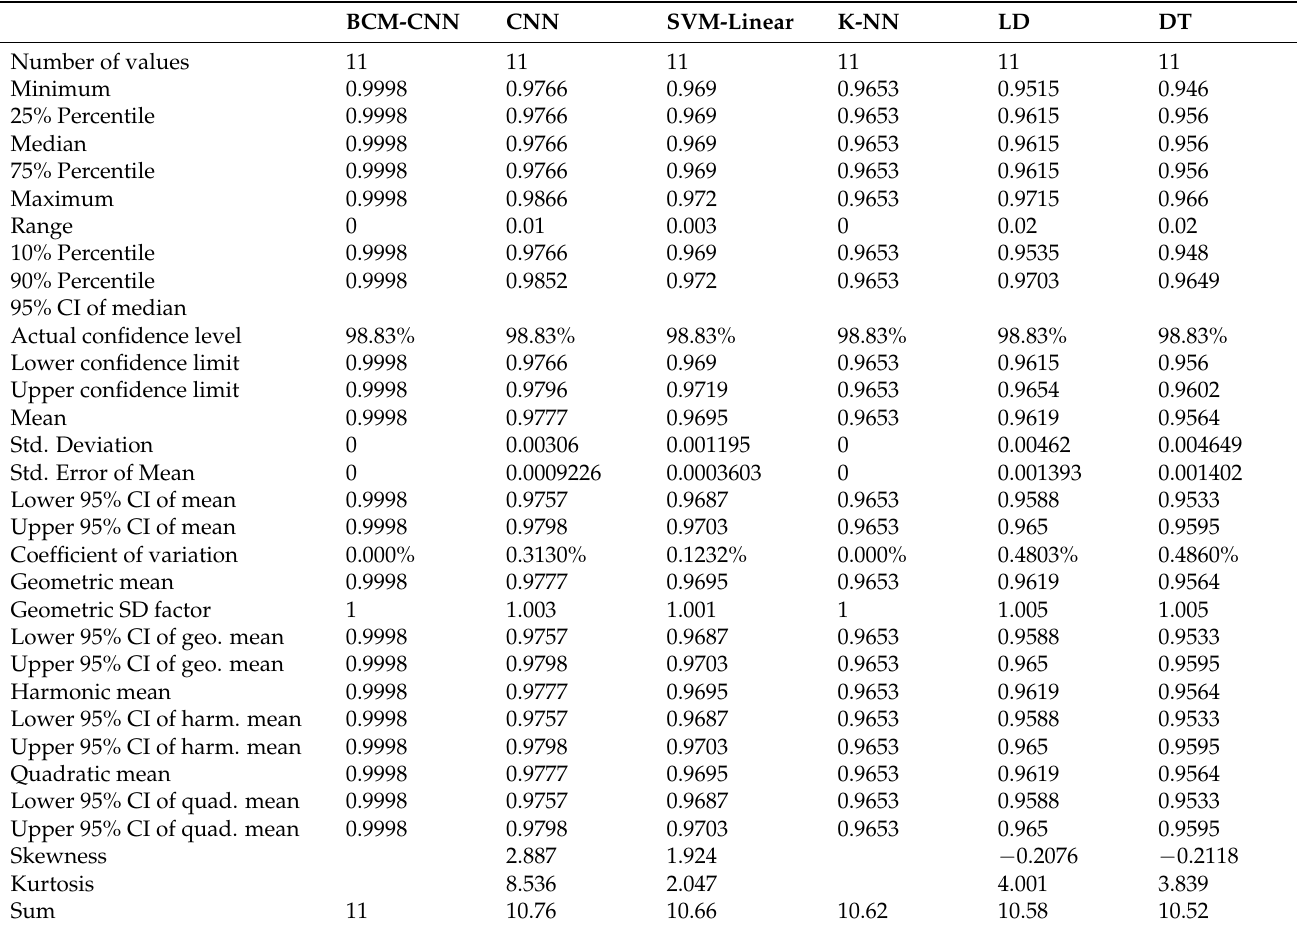
Table 7. Proposed BCM-CNN classifier’s statistical description and a comparison of classifiers.